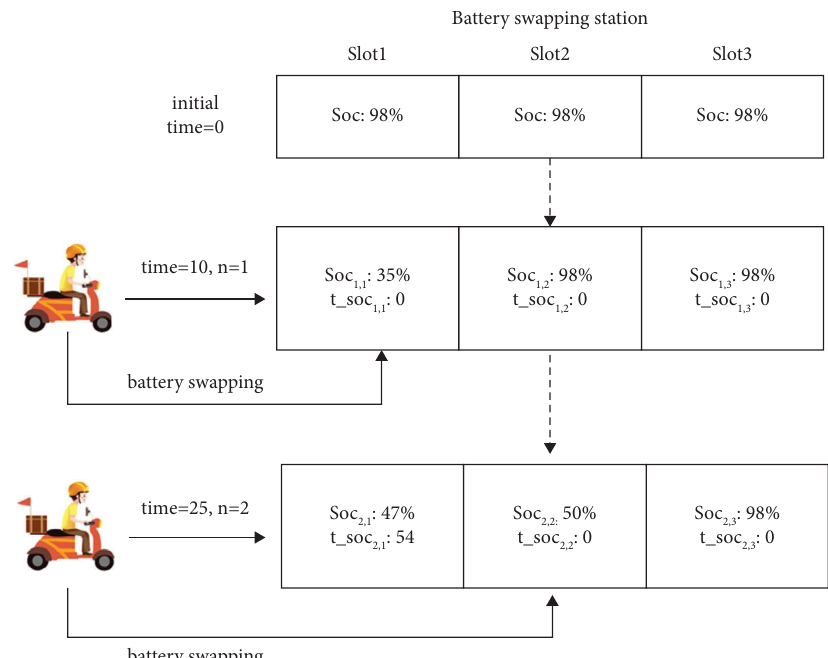
Figure 9: Explanation of variables soc